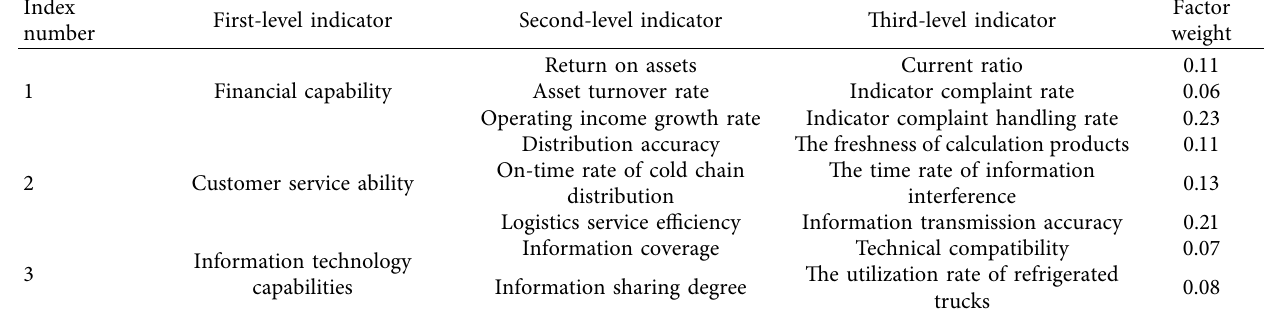
Table 1: Quantitative indicators of input-output efficiency.